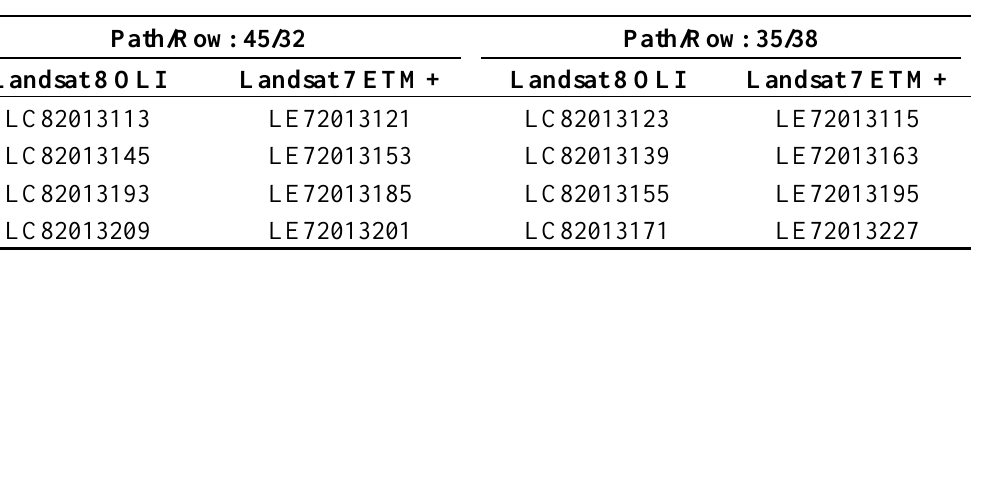
Table 5. Satellite data used in the time series